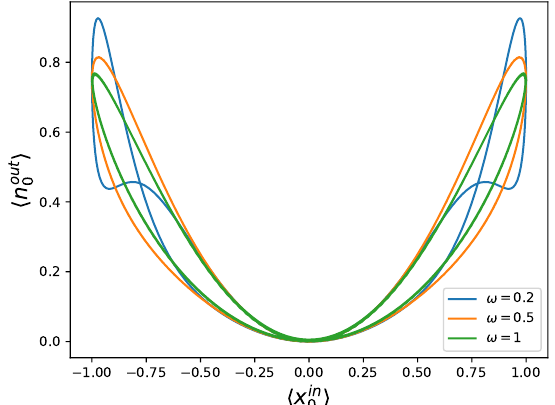
(cid:105) of the outgoing beam versus the quadrature of the input state Figure 5. Number of photons (cid:104) n out 0 (cid:104) x in (cid:105) for coherent states, displaying a pinched hysteresis loop, proving that this system behaves as 0 a memristor. We have plotted this for three different frequencies, namely ω = 0.2 (blue), ω = 0.5 (orange), and ω = 1 (green), exemplifying that the area of the loop decreases for higher frequencies. (cid:105) max = 1 (see Appendix A for directions of the hysteresis We have used φ ( 0 ) = π , ω 0 = 1, and (cid:104) x in 0 2